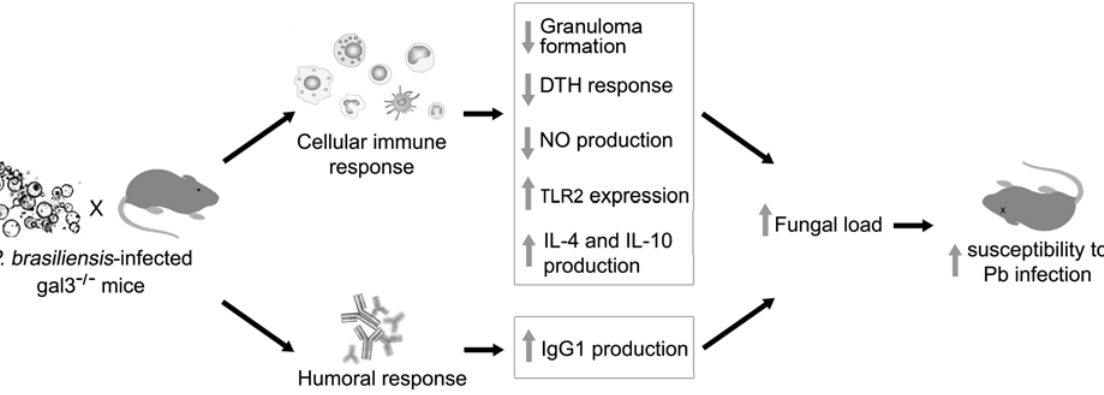
Figure 8. Possible role of galectin-3 during a fungal infection, as suggested by the immune response of gal3 2 / 2 mice to the inoculation of P.brasiliensis yeasts. Mice deficient for the galectin-3 gene were infected, and several aspects of the immune response mounted by these mice are summarized in the figure.